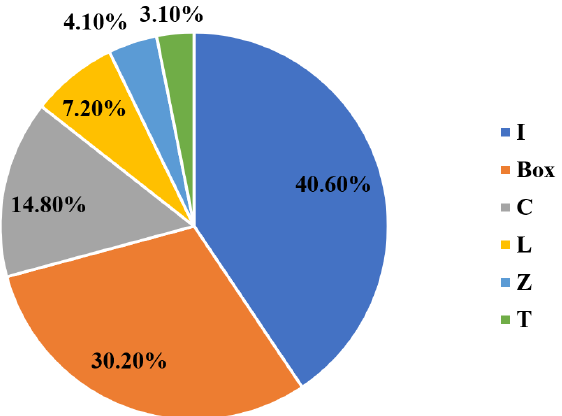
Figure 2. The percentage share of each cross-sectional shape in civil structural applications along with the studies (experimental and numerical) characterising its local buckling behaviour (I-shape: [17,52,53,57–92], Box-shape: [17,29,53–56,58,63,72,75,76,82,85,93–108], C-shape: